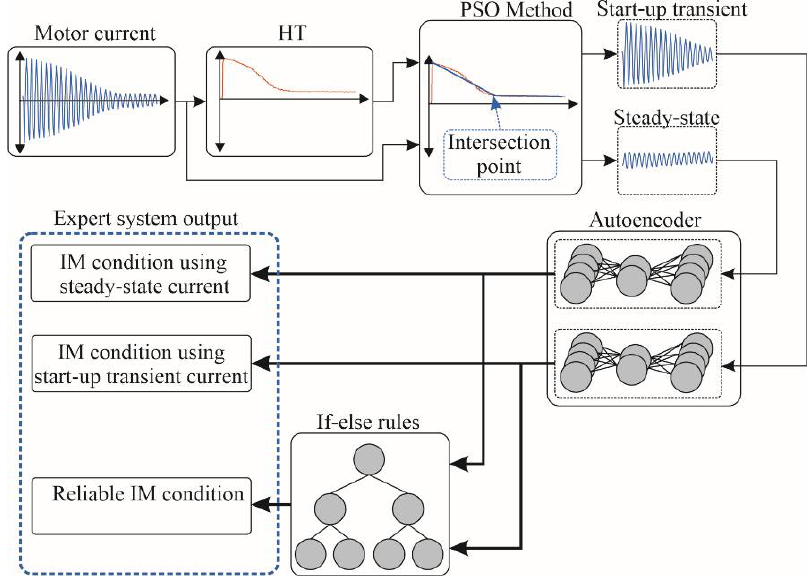
Figure 1. Expert system methodology for induction motor diagnosis.